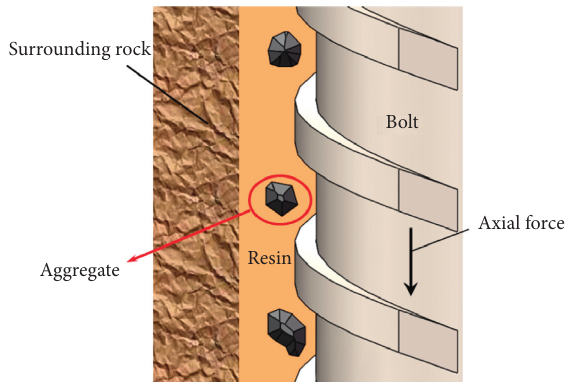
Figure 2: Schematic diagram of adding aggregate into resin